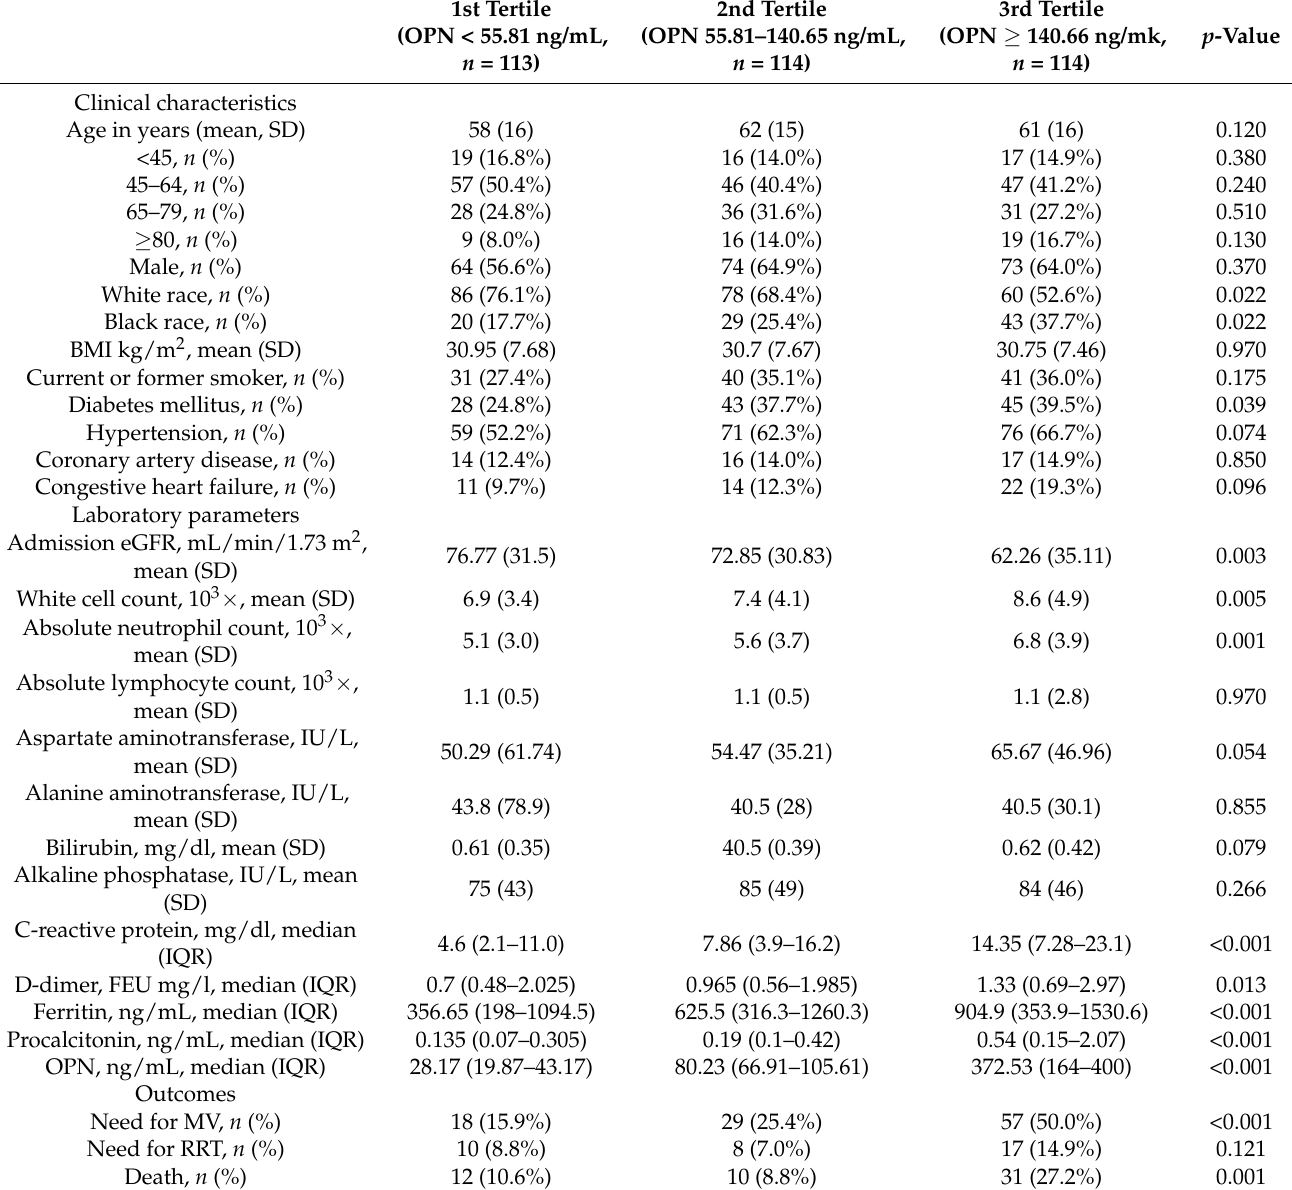
Table 3. Clinical characteristics and inflammatory markers stratified by OPN